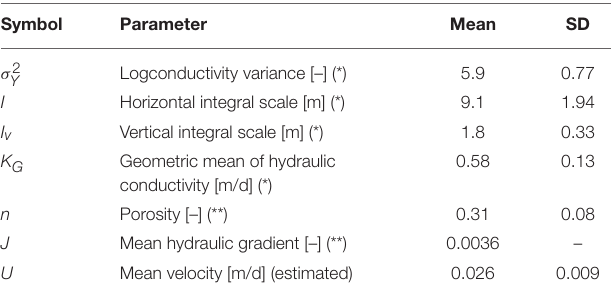
TABLE 1 | Mean and standard deviation (SD) for the MADE-1 parameters employed in the present